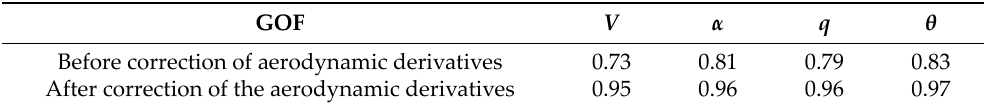
Table 6. Goodness of fit of the wind tunnel virtual flight test with free flight. GOF V Before correction of aerodynamic